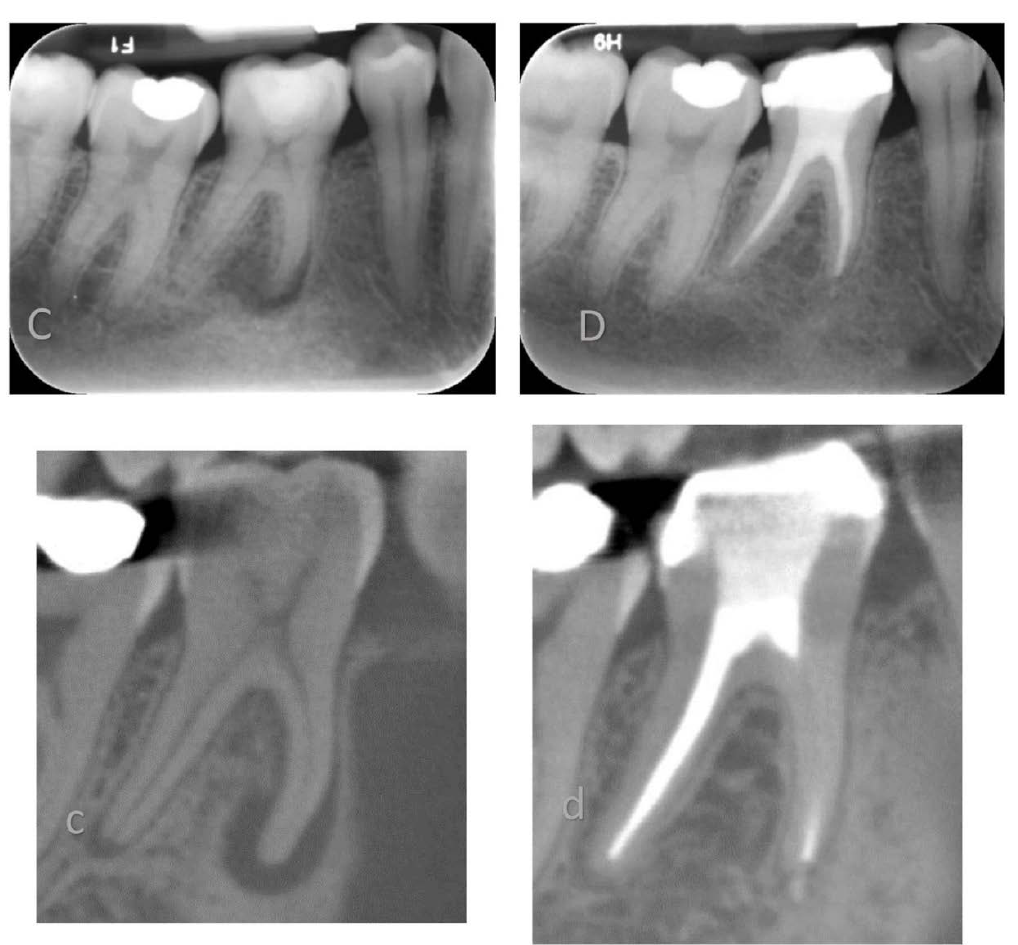
Figure 3. Lower right mandibular first molar root filled using a single cone technique and BioRoot TM RCS. Preoperative PA X-ray ( C ) and CBCT ( c ) and recall PA X-ray ( D ) and CBCT ( d ) at 12 months.